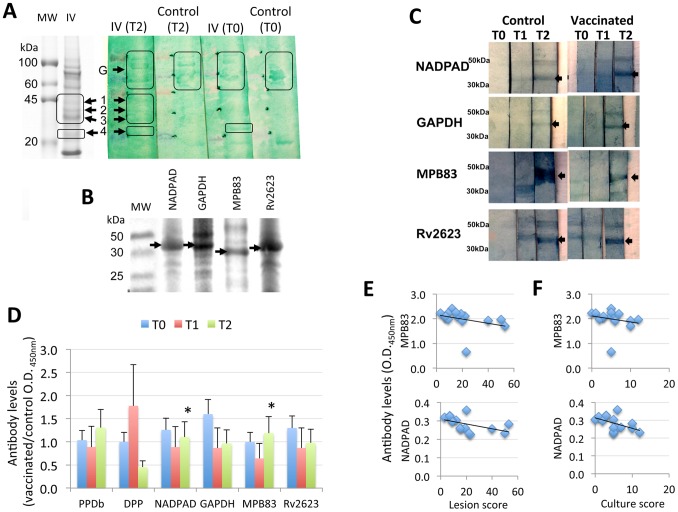
Oral vaccination with IV induces an antibody response in wild boar.(A) Identification by Western blot and mass spectrometry of mycobacterial proteins recognized by antibodies in IV vaccinated wild boar. Identified proteins are indicated with arrows in Coomassie-blue stained 12% SDS-polyacrylamide gel (left panel) and Western blot with pooled sera from vaccinated and control animals at T0 and T2 (right panel) with 10 µg IV proteins. MW, molecular weight markers. (B) Expression of recombinant proteins in E. coli. Ten µg of purified proteins were loaded per well in a 12% SDS-polyacrylamide gel. Recombinant proteins are indicated with arrows. MW, molecular weight markers. (C) Western blot analysis of recombinant mycobacterial proteins using pooled sera from IV vaccinated and control animals at T0, T1 and T2. Ten µg of purified proteins were loaded per well in a 12% SDS-polyacrylamide gel. The position of the recombinant proteins is indicated with arrows. (D) Antibody levels against mycobacterial proteins were determined by ELISA in serum samples from vaccinated and control animals and O.D.450 nm values (Ave+S.D.) were compared at each time point between vaccinated and control groups by Student’s t-test with unequal variance (*P≤0.05). (E, F) Correlation analysis between antibody levels against NADPAD and MPB83 mycobacterial proteins in vaccinated and control animals and (E) lesion score or (F) culture score at T2 (N = 15).